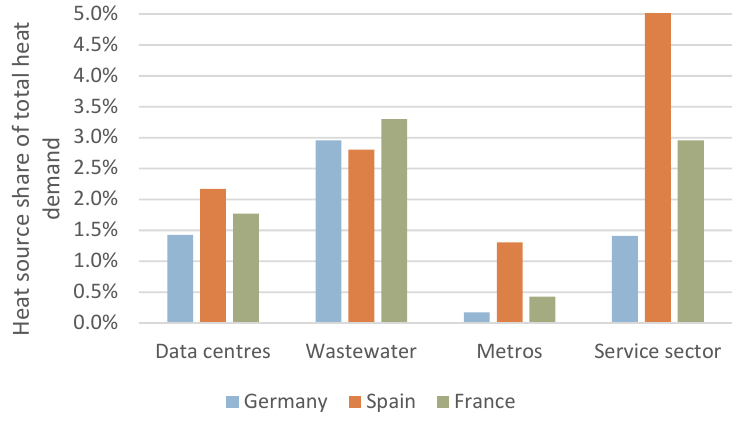
Figure 5. The available excess heat source potentials as a share of the total heat demands for 2015. Service sector cooling in Spain is 22%.